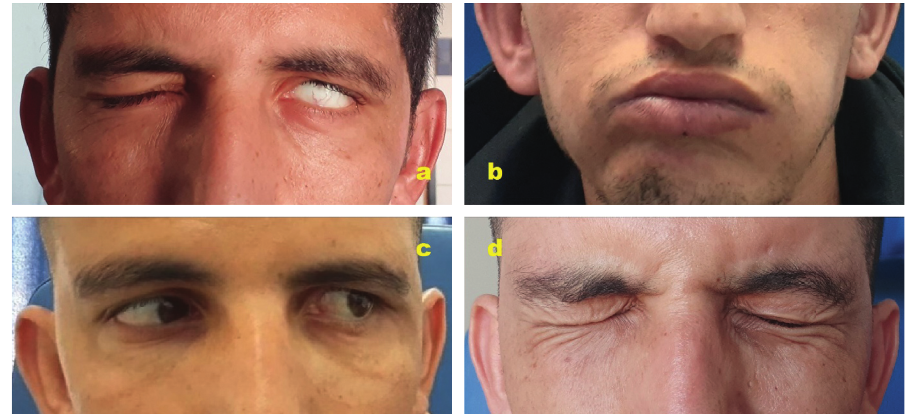
Figure 3: (a) Two-week follow-up: improvement of the right-side facial palsy. (b) Two-month follow-up: development of the mouth movement exhibiting the progressive return of function of the lower branches of the facial nerve. (c) Two-month follow-up: recovery of the left abducens palsy. (d) Six-month follow-up: evolution of the bilateral facial